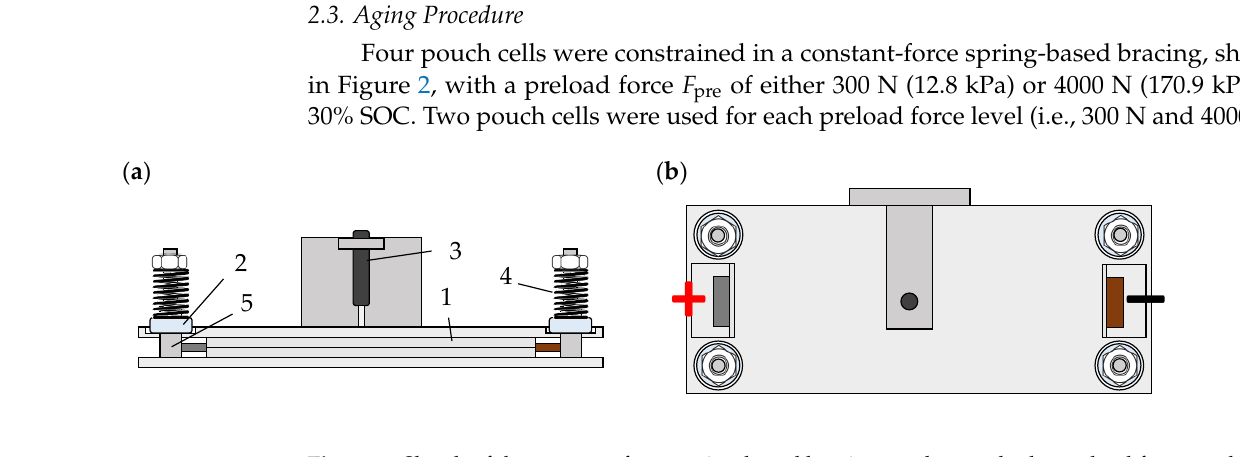
Figure 2. Sketch of the constant-force spring-based bracing used to apply the preload force on the cell upon aging. ( a ) Setup cross section, tested pouch cell (1), ring load cells (2), inductive displacement transducers (3), springs (4) and guiding shafts (5). ( b ) Setup top